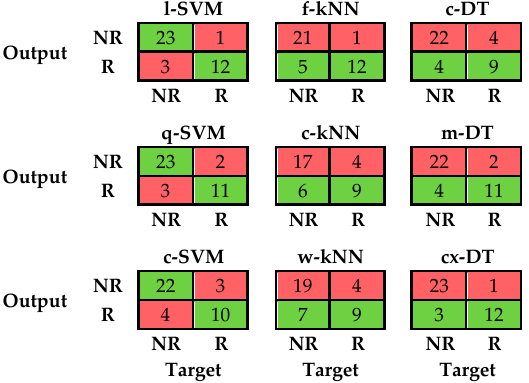
Figure 4. Confusion matrices for all the tested classifiers. NR and R stand for no risk and risk class.